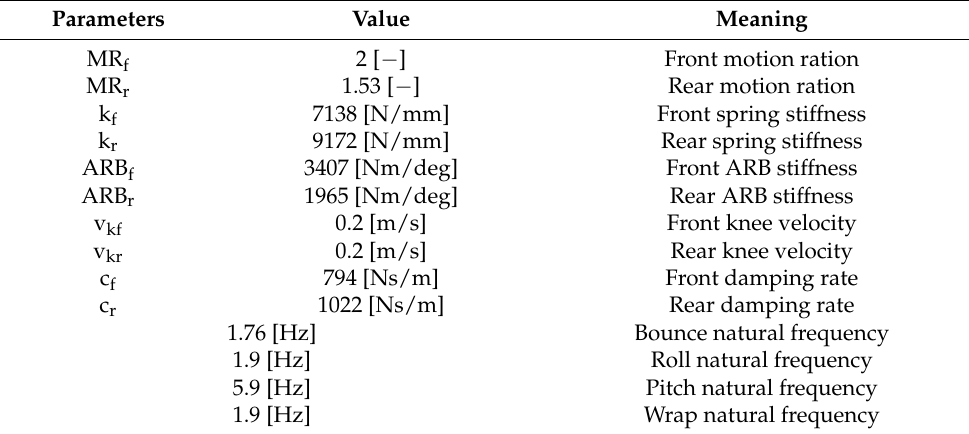
Table A2. Passive Suspension Parameters.